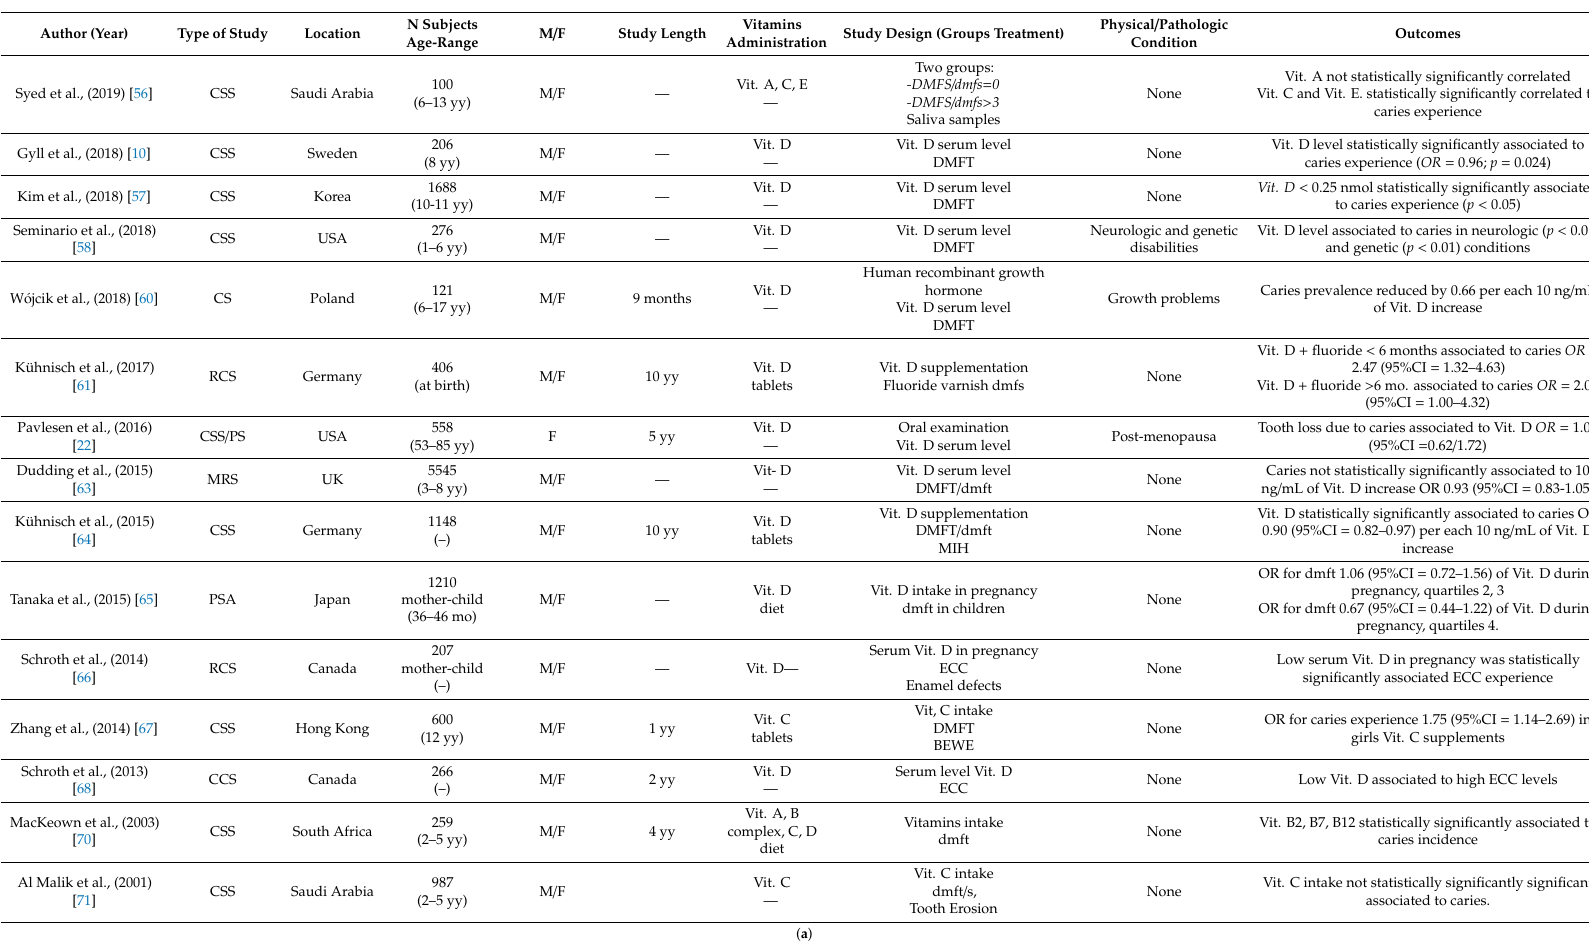
Table 3. Main characteristics of the studies included regarding hard dental pathological processes (( a ) caries and ( b ) enamel defects).